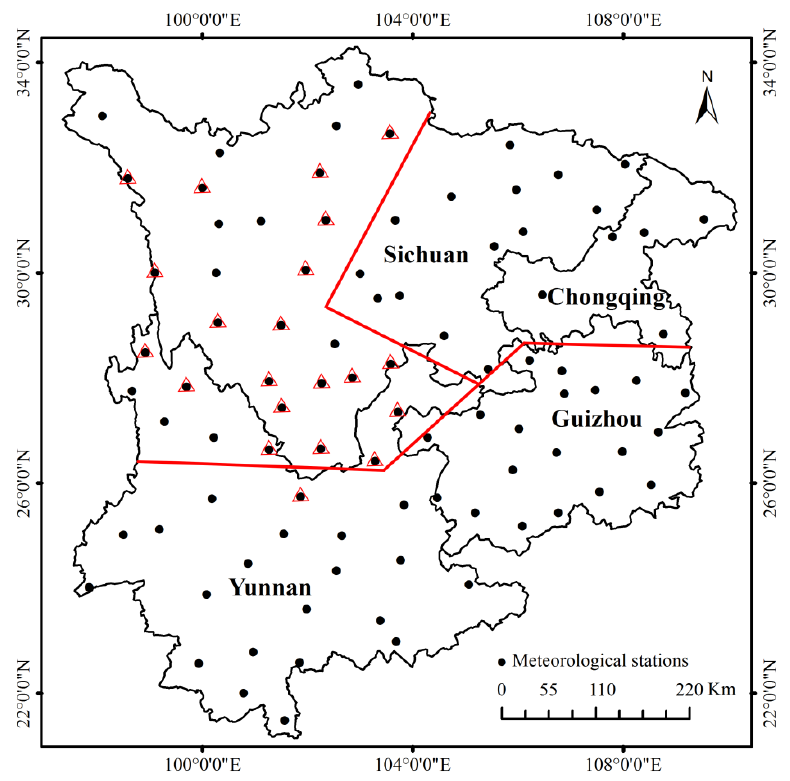
Figure 1. Location of the weather stations in southwestern China. (The red lines were dividing lines which divided the study region into three zones; and ∆ in red represents the weather stations in arid river valley region which belongs to one of the three parts.)